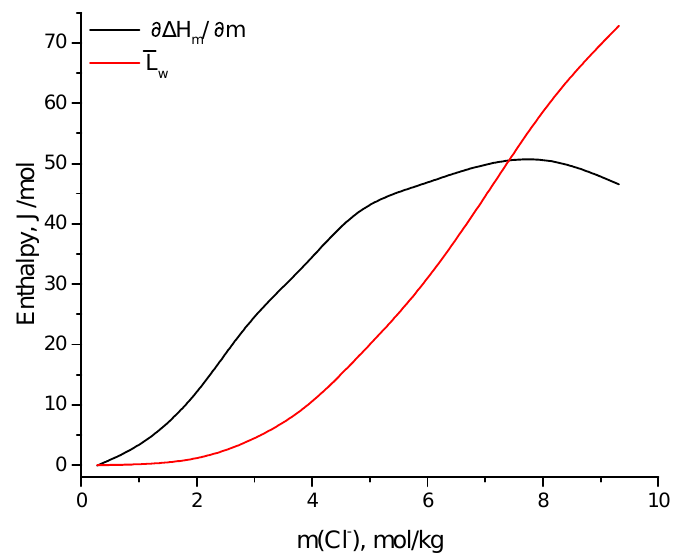
Figure 6. Partial molar ( ∂ ∆ H m / ∂ m ) and relative partial molar (¯ L w ) enthalpies dependency on total Cl –